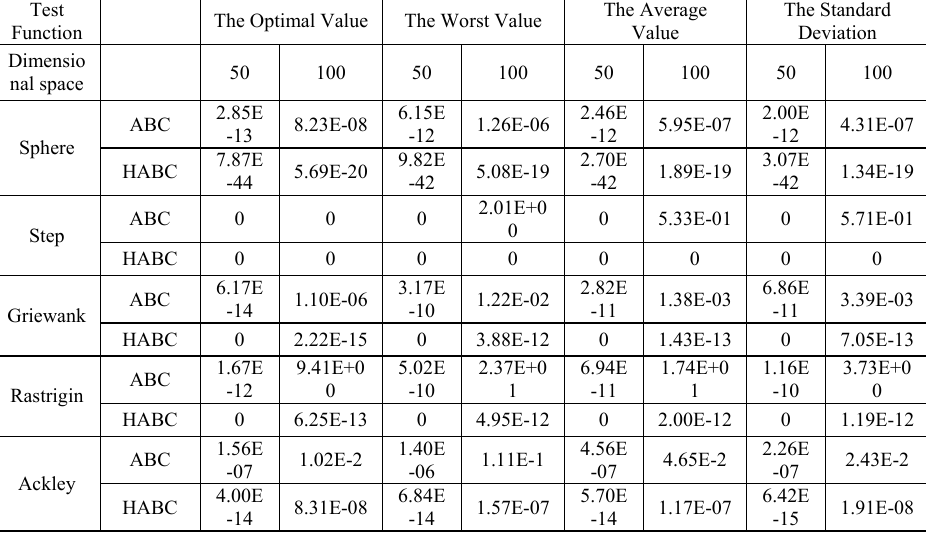
Table 1. HABC algorithm and ABC algorithm run 30 times in 50- dimensional space and 100- dimensional space.